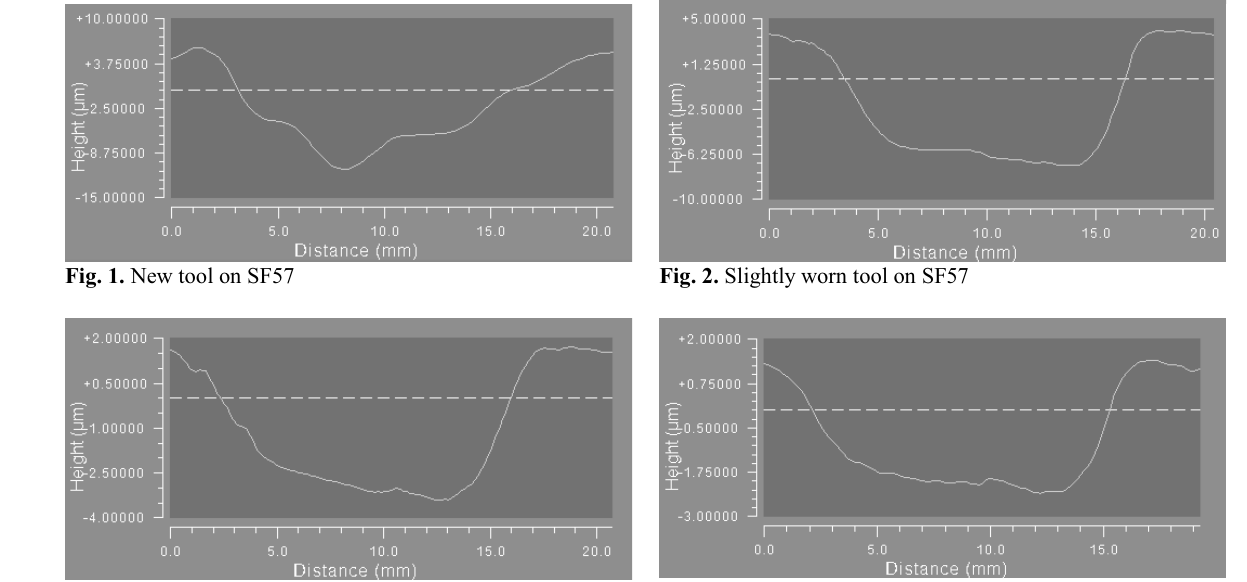
Fig. 3. Slightly worn tool on N-SF57 Fig. 4. Slightly worn tool on